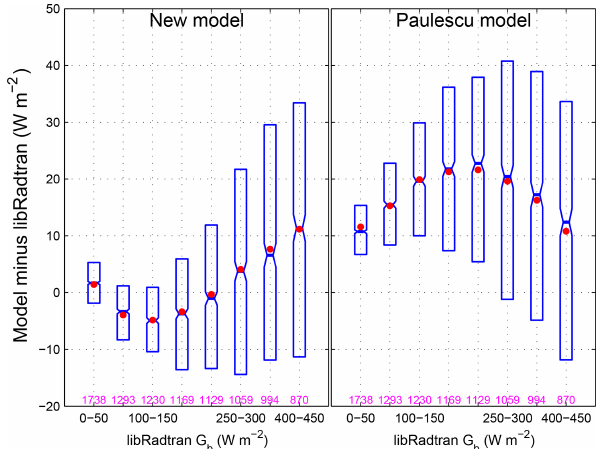
Figure 1. Dependence of deviations between estimated and libRad- tran G b for the new and Paulescu models. The red dot indicates the mean, and the limits of the boxes are the first, second (median) and third quartiles. The pink number is the number of data in a DNI